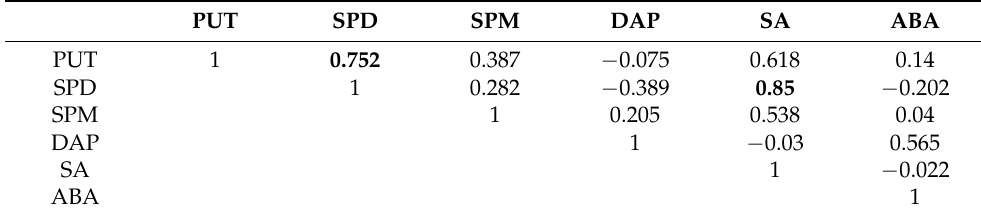
Table 3. Correlation analysis on the polyamine, salicylic acid and abscisic acid contents in the leaves of wheat plants. Correlations significant at 0.05 are highlighted in bold. DAP: 1,3-diaminopropane; PUT: putrescine, SPD: spermidine, SPM: spermine, SA: salicylic acid; ABA: abscisic acid. PUT SPD SPM